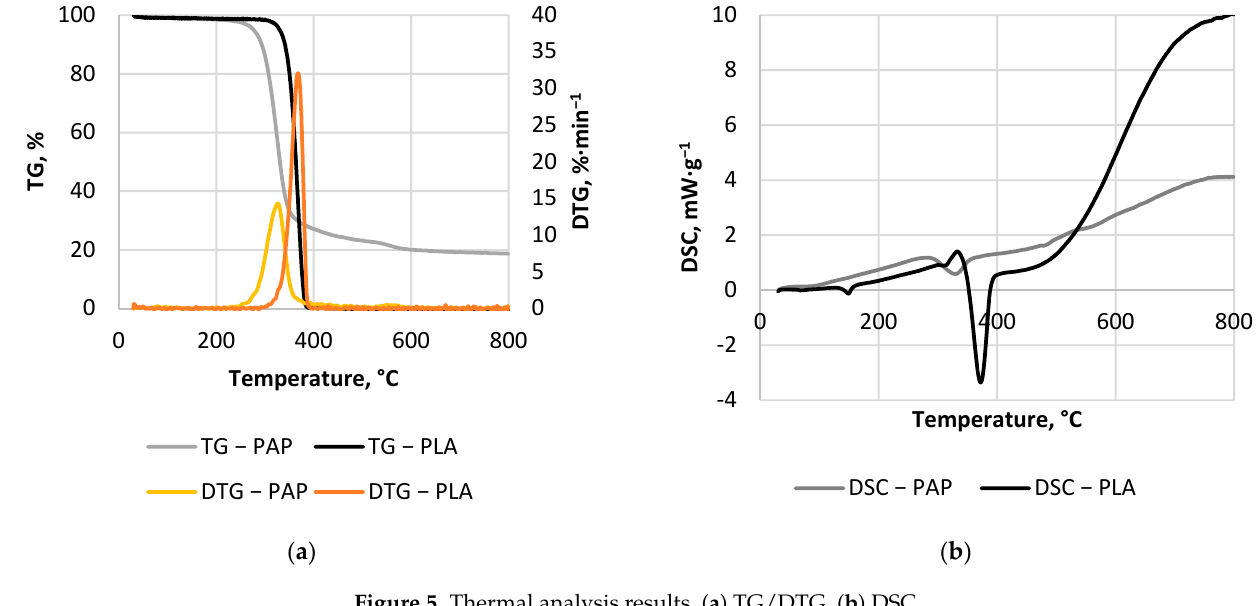
Figure 5. Thermal analysis results, ( a ) TG/DTG, ( b ) DSC.